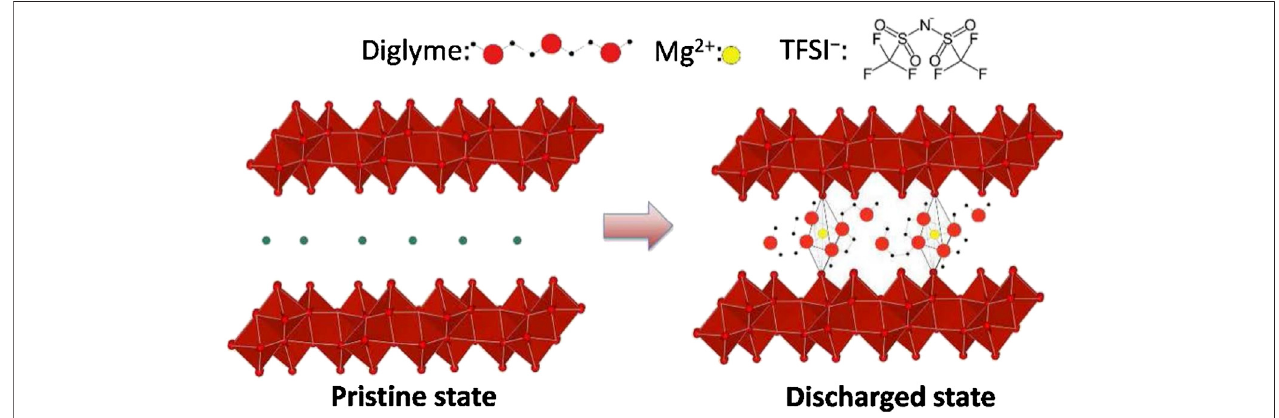
FIGURE6| SchematicoftheV 2 O 5 (cid:129) nH 2 Ocrystalstructure inthepristine (left) and discharged (right) states. Reprinted withpermission fromChem.Mater. 2016, 28, 2962 – 2969. Copyright 2016 American Chemical Society.